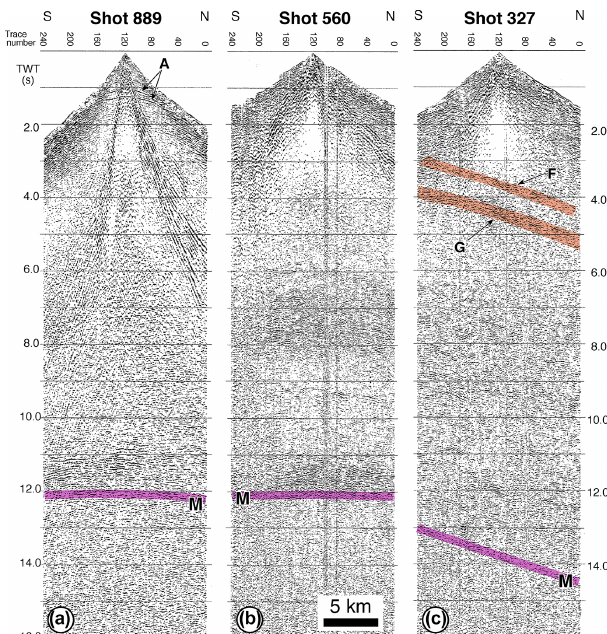
Figure 5. Three shot gathers from ESCIN-2 deep seismic reflection profile. (a) Shot gather from the Duero basin (A reflections from the Cretaceous levels that drape the bottom of the basin). (b) Shot gather from the transition to the Cantabrian Mountains; note the increase in reflectivity below 6s and the base of horizontal Moho (M) at 12s. (c) Shot gather from the Cantabrian Mountains. North- dipping reflecting bands are more conspicuous than in the stack sec- tion (F and G). Moho is dipping to the north and reaches a maximum depth of almost